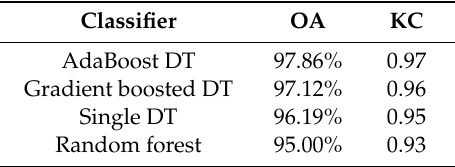
Table 5. Accuracy assessment of various tree-based classifiers.